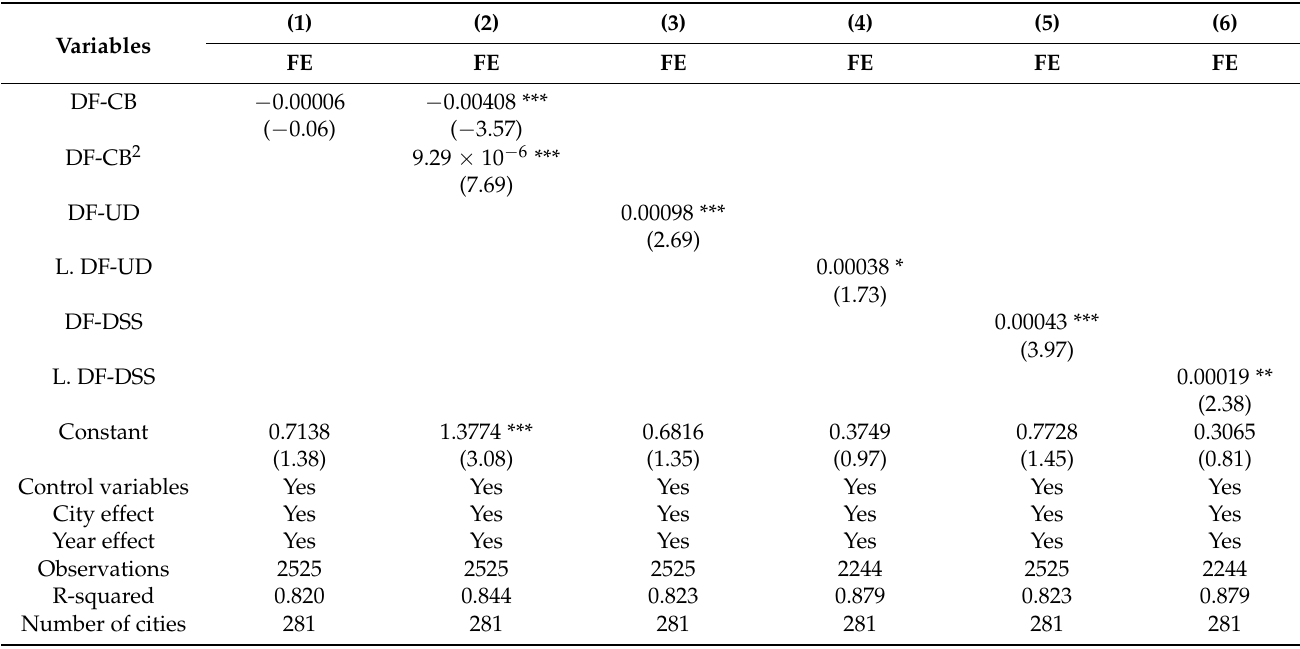
Table 5. Coverage breadth, digital support services, and usage